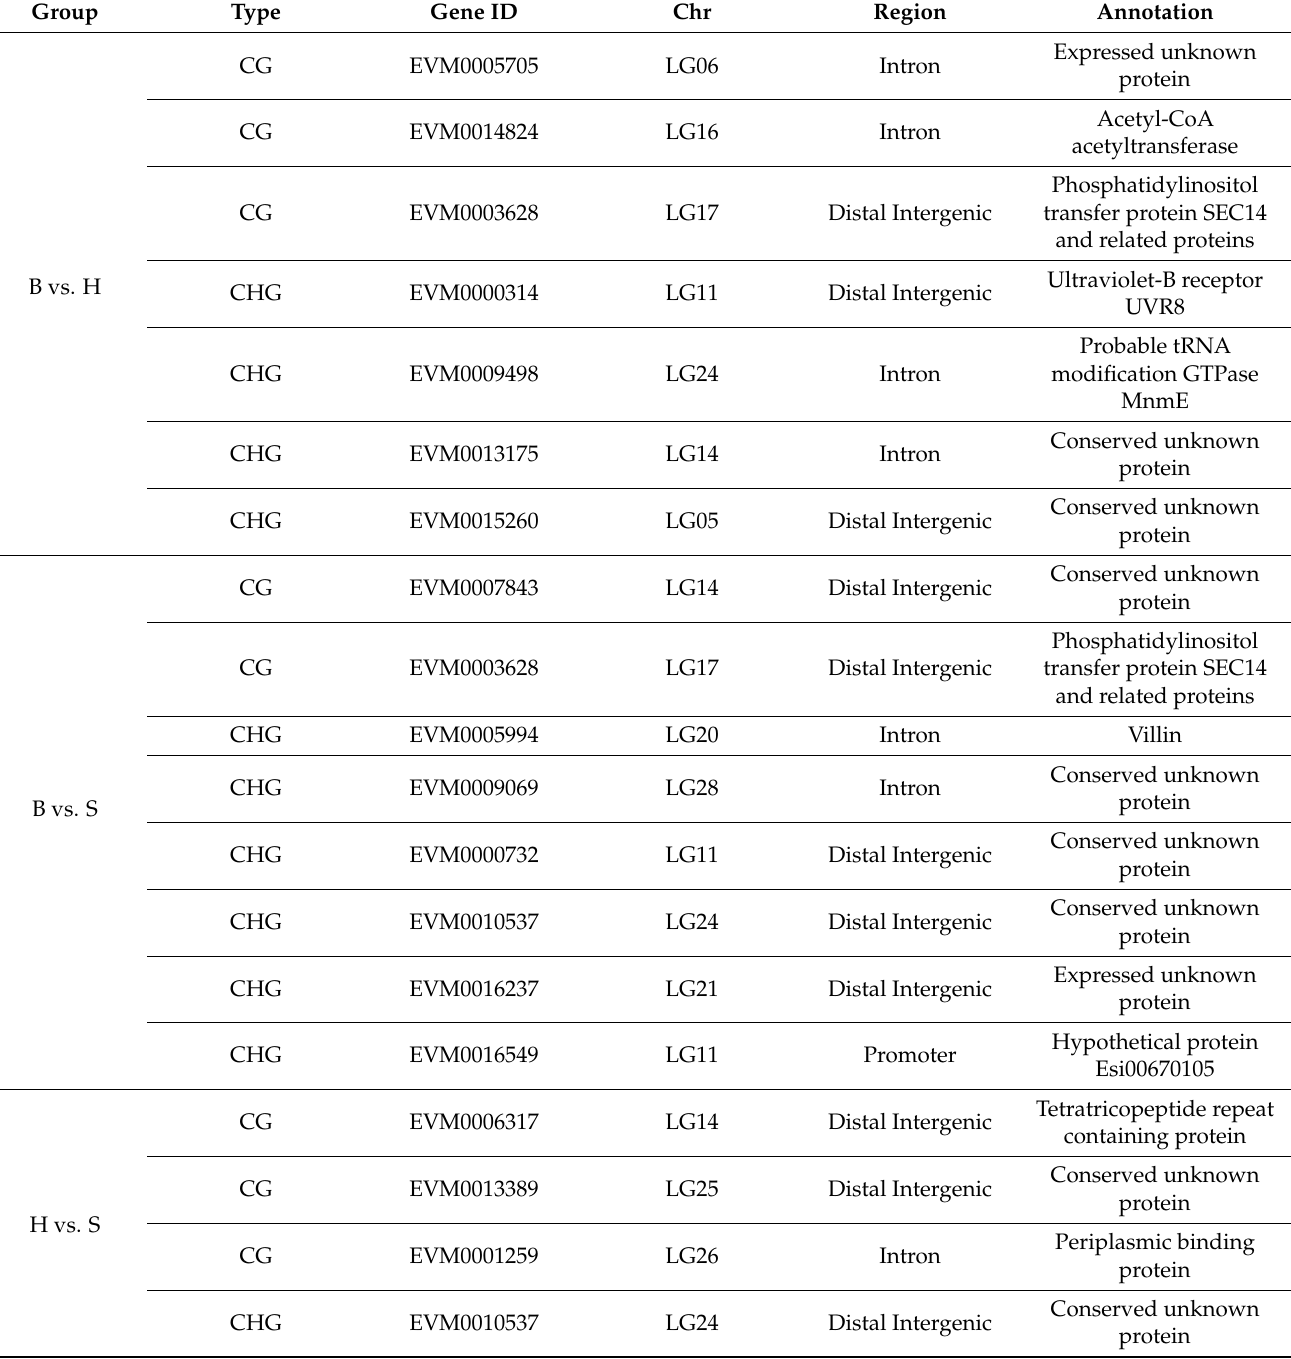
Table 2. The location and annotation of DMR associated genes of both CG and CHG sites among holdfast (H), stipe (S) and blade